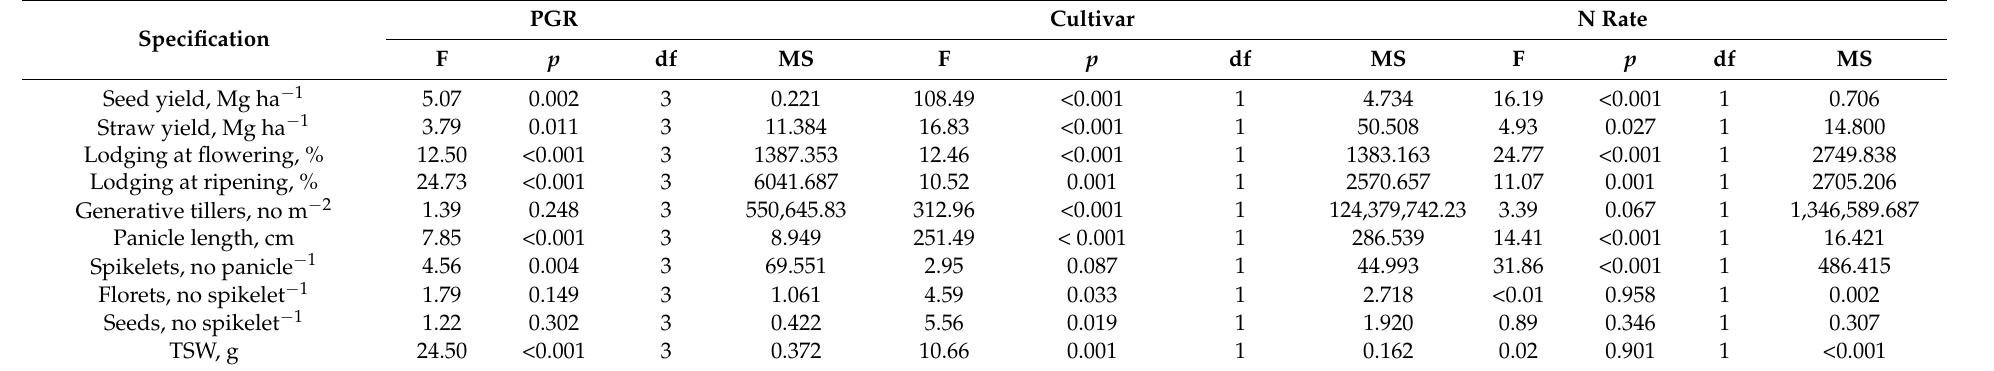
Table 7. Analysis of variance ( p and F values) for seed and straw yield, lodging index and panicle characteristics of red fescue generative tillers ( Festuca rubra ssp. rubra cv. Nista and F . r . ssp. commutata cv. Dorosa), for two production years and two field experiments.